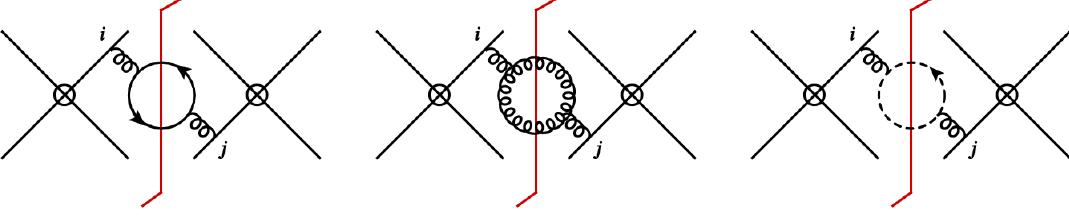
Figure 4 . Bubble diagrams contributing the NNLO soft